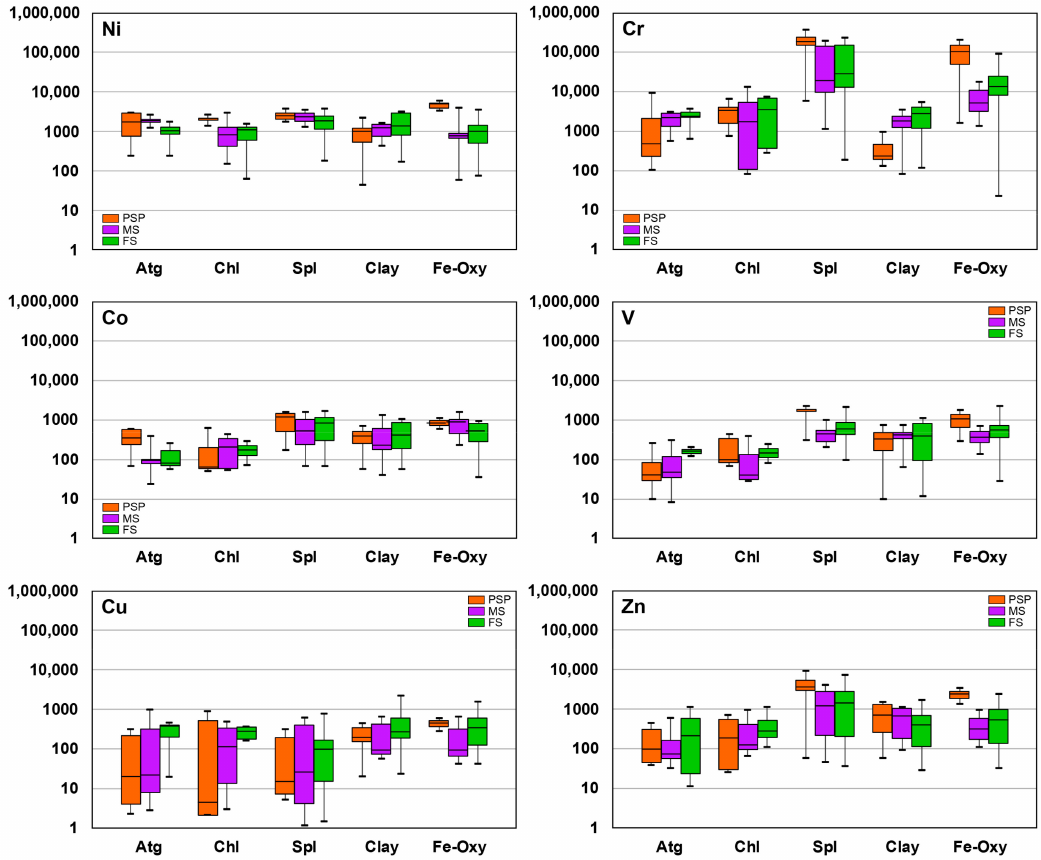
Figure 7. Box plots showing statistical parameters for contents (in ppm) of Ni, Cr, Co, V, Cu, and Zn in the main mineral species occurring in soils on PSP, MS, and FS bedrocks. Vertical lines show the range in contents, the boxes are bounded by the 1st and 3rd quartile, whereas the horizontal line inside the box represents the median value. Statistical parameters are based on the following number of analyses: Atg = 48; Chl = 23; Spl = 70; Clay = 52; Fe–Oxy = 85. Abbreviations: Atg: antigorite; Chl: